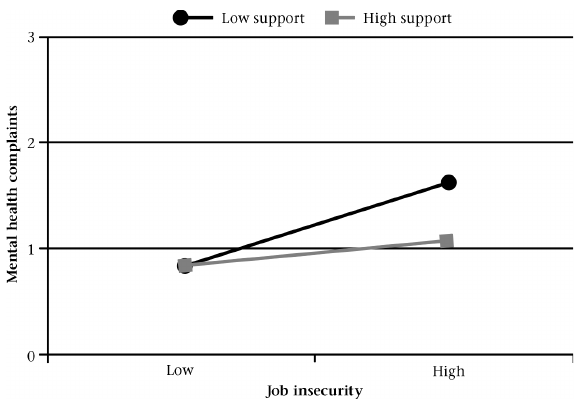
Figure 1: Interaction between job insecurity and work-based support on mental health